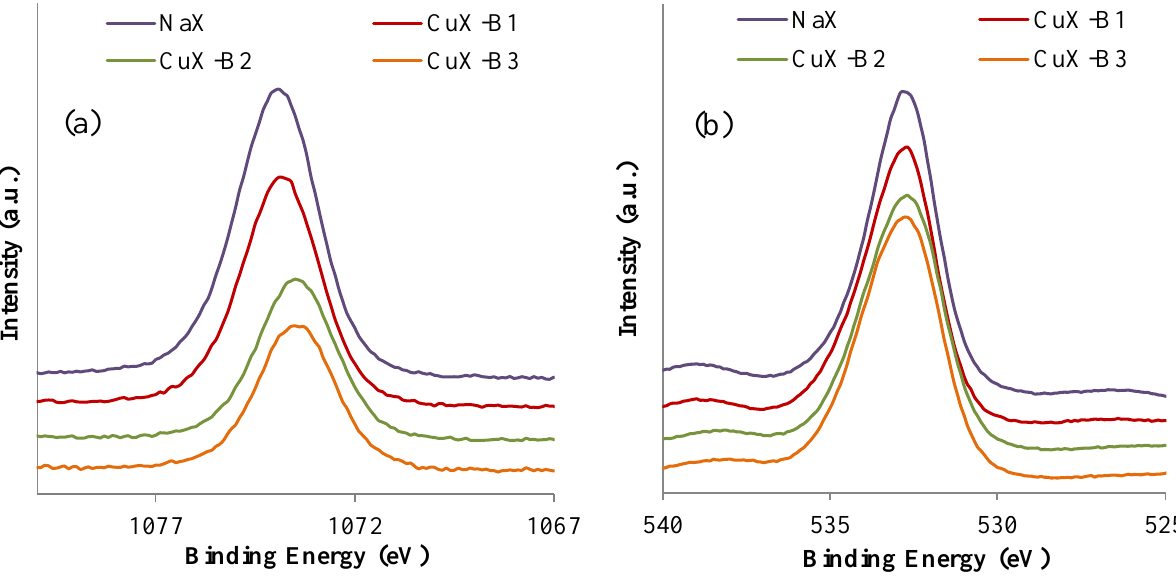
Figure 6. ( a ) Na 1s and ( b ) O 1s XPS spectra of the NaX and copper-exchanged